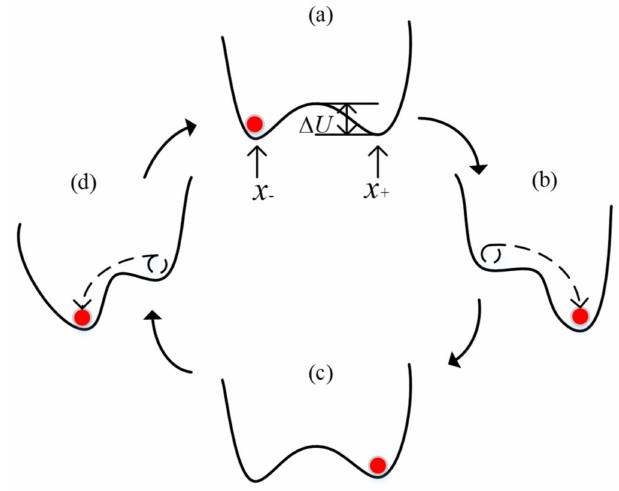
Figure 2. Schematic diagram of Brownian particle jumping between bistable potential wells: ( a ) At t = T; ( b ) At t = T/4; ( c ) At t = T/2; ( d ) At t =